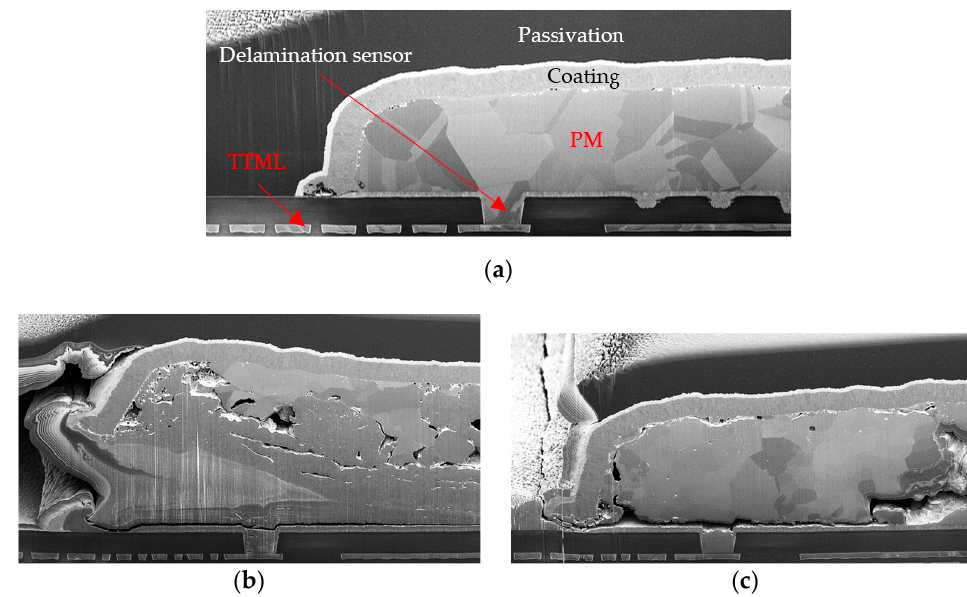
erated at 100%AA; ( c ) Sample operated at 90%AA.